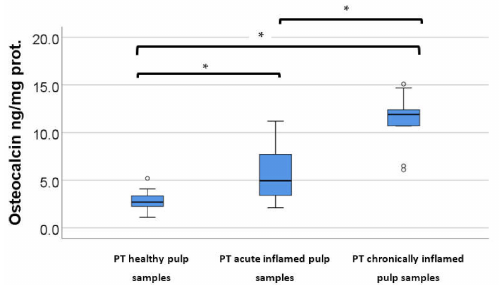
Figure 3. Osteocalcin protein levels (ng/mg) in the control group versus acute/chronic pulpitis. (* Indicates statistically significant differences). The circles in the graphic are an indication that an outlier is present.)